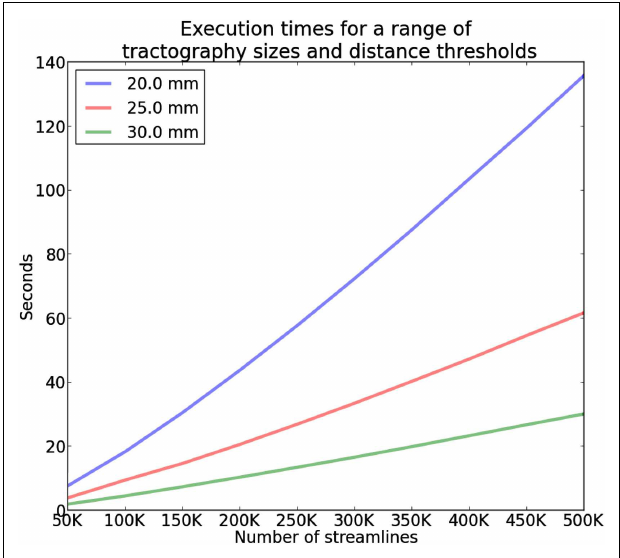
FIGURE 6 |Time comparisons of QB using different clustering thresholds and different number of streamlines. Time increases linearly as the number of streamlines